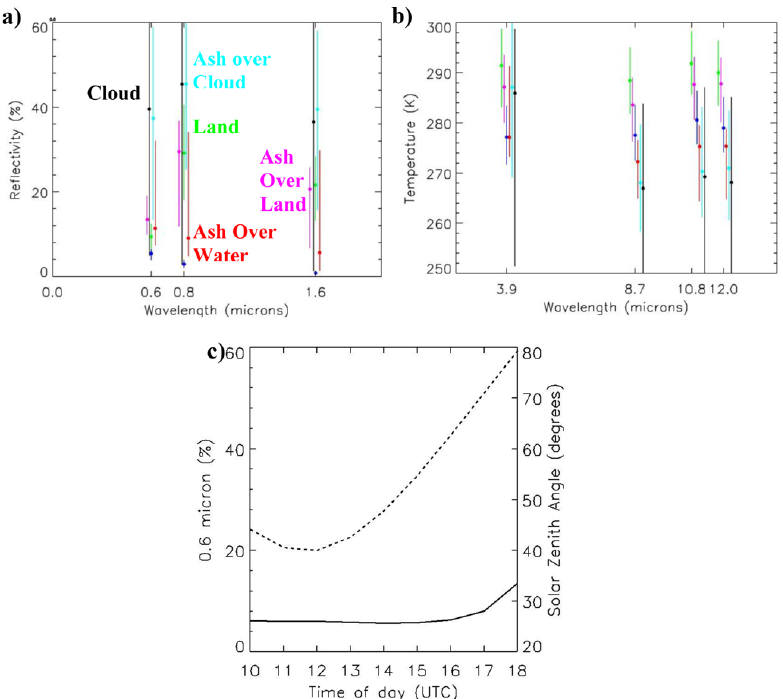
Fig. 2. (a) Wavelength-versus-reflectivity plot for the three SEVIRI reflectivity channels showing the mean along with minimum and maxi- mum reflectance for the 80 extracted samples where the ocean is blue, land is green, ash over water is red, ash over land is pink, ash above cloud is light blue, and cloud is black. (b) : same as (a) except wavelength versus temperature for four SEVIRI temperature channels is displayed. (c) 0.6µm reflectivity and solar zenith angle for a clear-sky pixel over the water on 5 May 2010 from 10:00 to